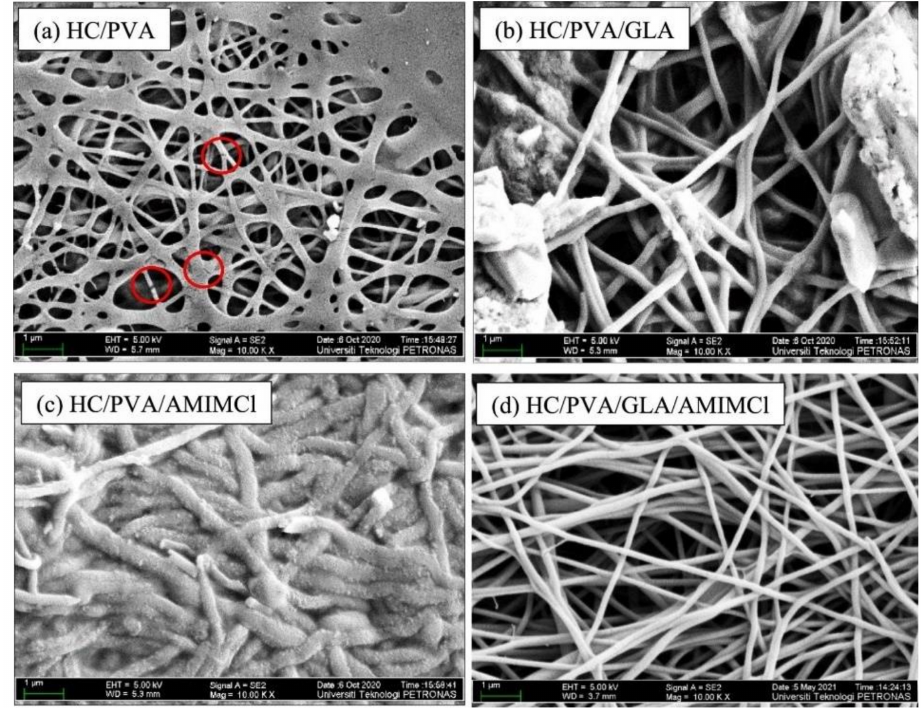
Figure 5. FESEM images of the original and modified HC/PVA nanofibers. Reprinted with permis- sion by